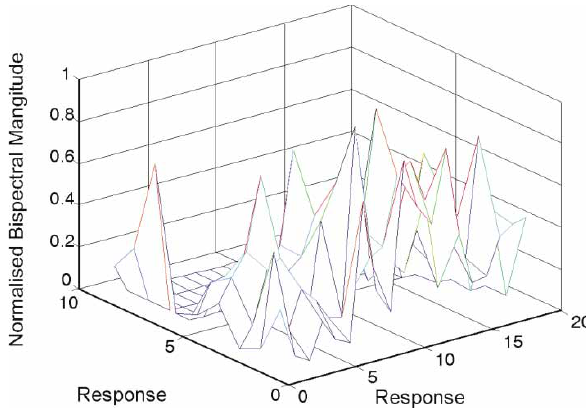
Fig. 8. Bispectrum of difficulties in implementing waste mana- gement